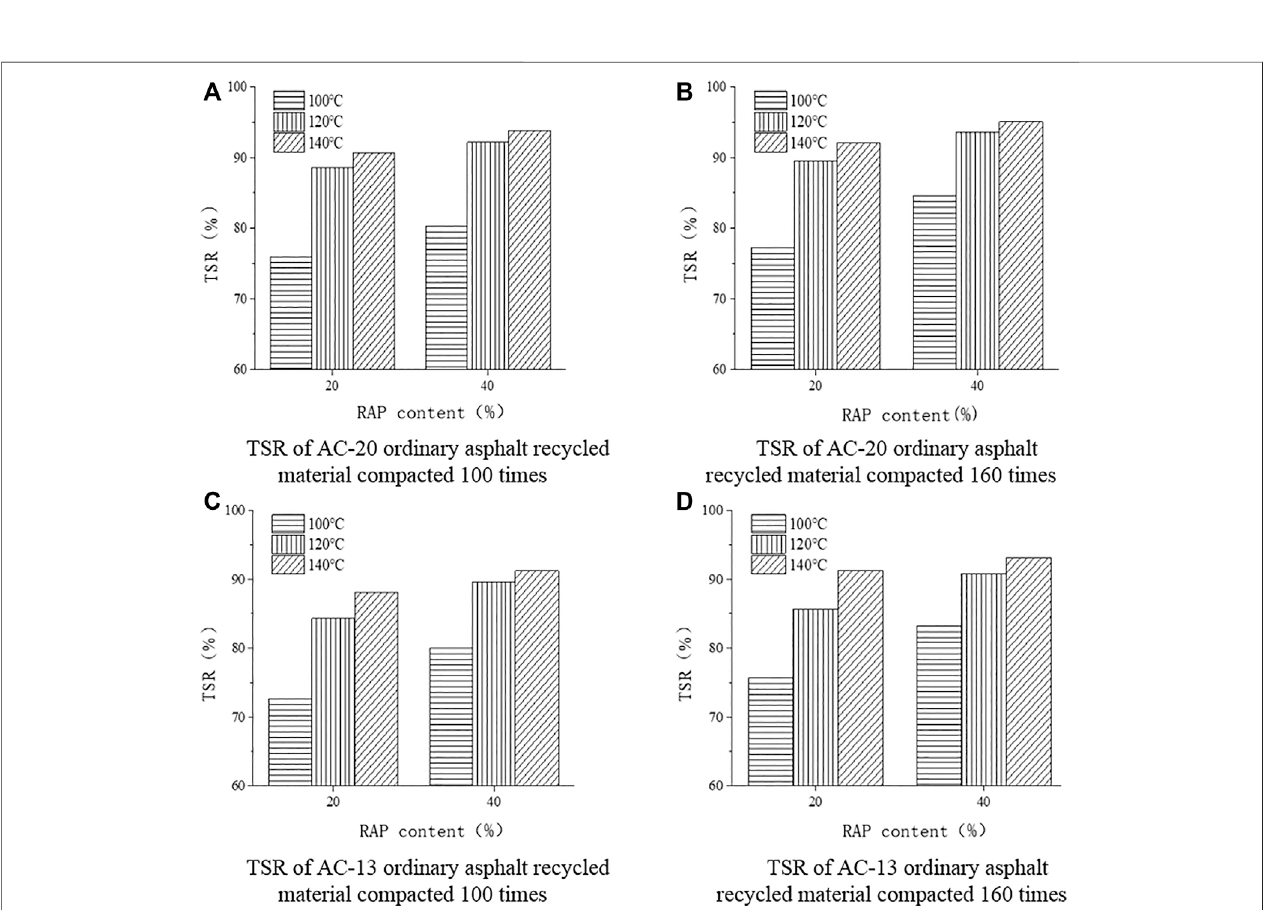
FIGURE 7 | TSR values of each asphalt recycled